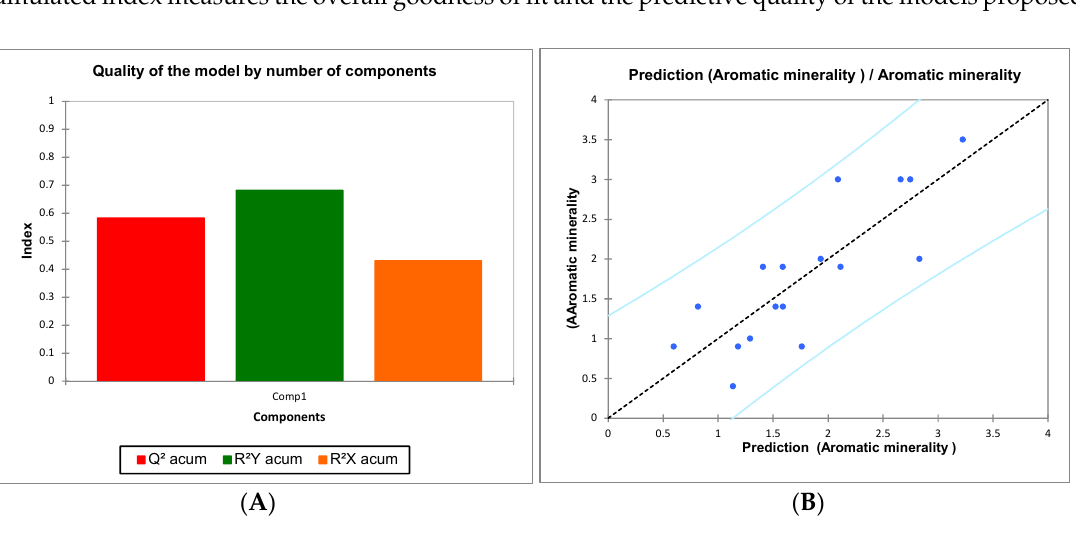
Figure 1. ( A ) Quality of fit of partial least squares (PLS) model; ( B ) Distribution of the seventeen wine samples of the study based on the volatile profile of wines for the olfactory “minerality” descriptor.